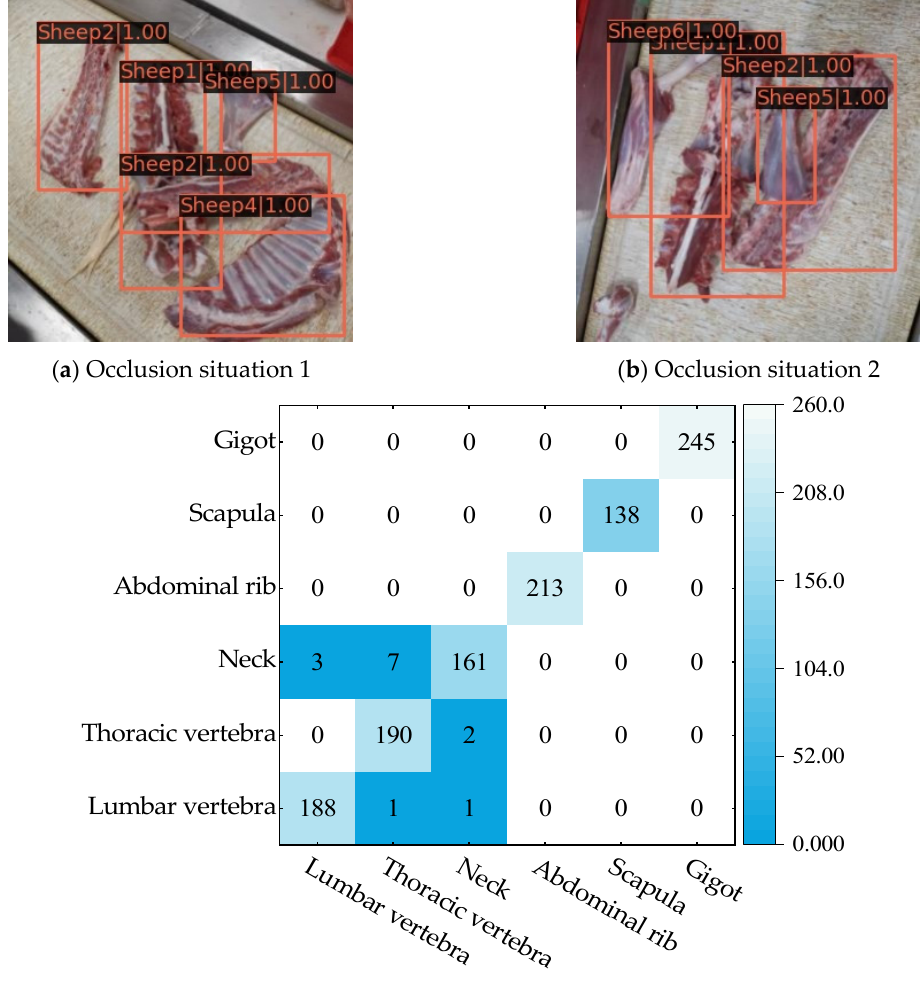
Figure 14. Partial results of the mu tt on multi-parts classi fi cation and detection under occlusion.